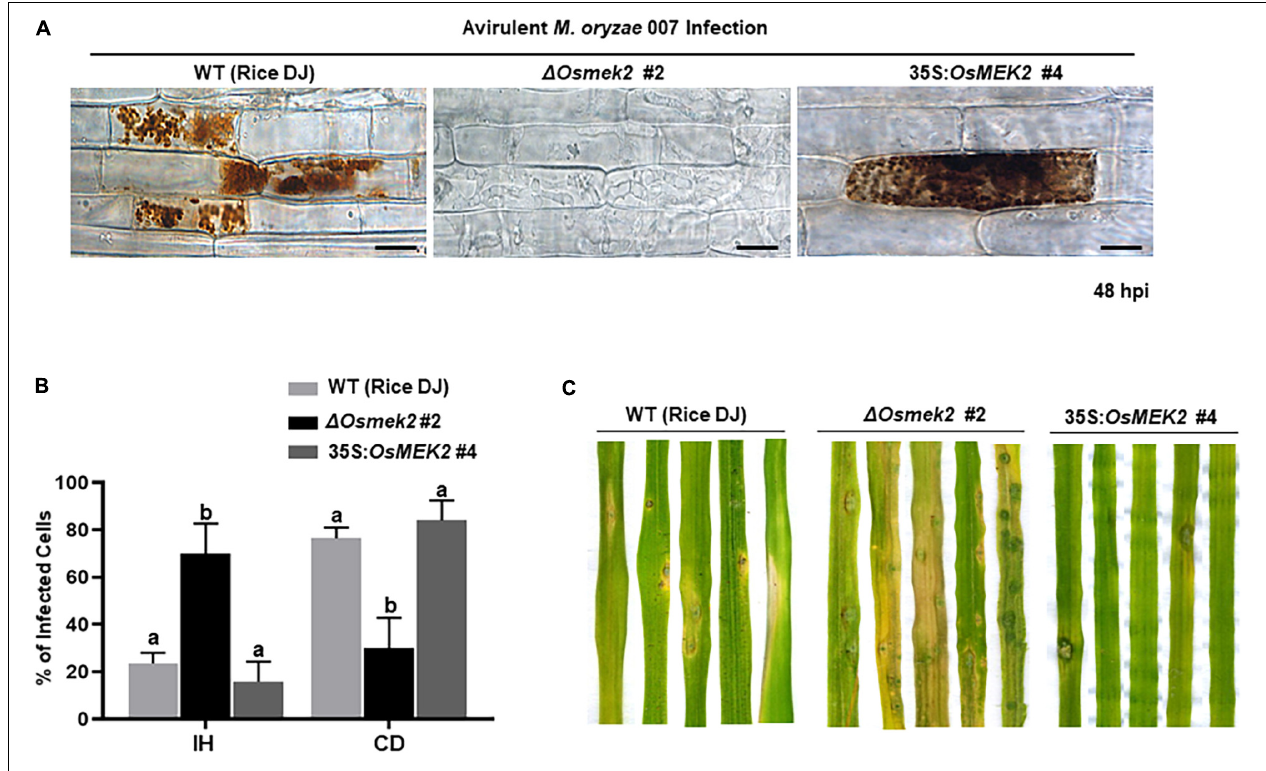
FIGURE 3 | Avirulent Magnaporthe oryzae 007 infection causes susceptible responses in the (cid:49) Osmek2 #2 knock-out plants, but resistant responses in the wild-type rice and 35S: OsMEK2 #4 overexpression plants. (A) Images of rice sheath epidermal cells infected with M. oryzae 007 (48 hpi). Rice leaf sheaths were inoculated with a conidial suspension (4 × 10 5 conidia mL − 1 ). M. oryzae 007 grew well and produced invasive hyphae in the OsMEK2 knock-out ( (cid:49) Osmek2 #2) rice, but induced hypersensitive cell death in wild-type (WT) rice cultivar DJ and OsMEK2- overexpressed (35S: OsMEK2 #4 ) plants. Images were captured using a fluorescence microscope. hpi, hours post-inoculation. Scale bars = 20 µ m. (B) Quantification of cell death and invasive hyphae in rice sheath cells infected with M. oryzae 007 (48 hpi). Results are presented as mean values ± SD; n = 4 leaf sheaths from different plants. Different letters above the bars indicate